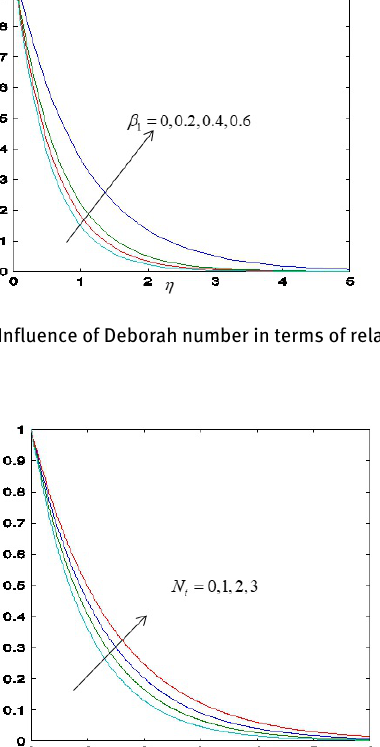
Fig. 12: Influence of Thermophoresis parameter N t on ϕ ( η )